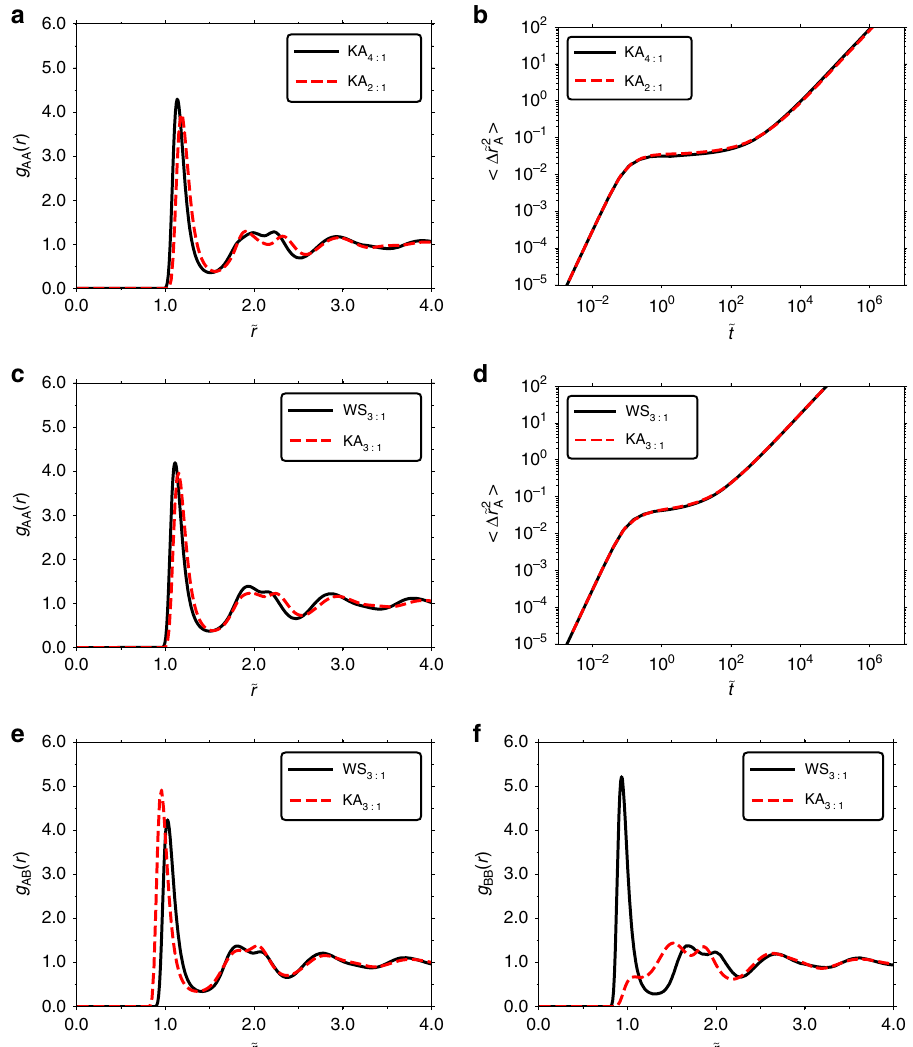
Fig. 5 Tests of radial distribution function (RDF) quasiuniversality where e r ¼ ρ 1 = 3 r and e t ¼ t ρ 1 = 3 ð k B T = m A Þ 1 = 2 . a AA-particle RDFs for the KA mixture for two different compositions (4:1 and 2:1) at state points with almost identical S ex and e D A . For 4:1 KA: ρ = 1.204, and T = 0.440 and for 2:1 KA: ρ = 1.400, and T = 0.550. b A-particle MSDs with details given in a , demonstrating almost identical reduced diffusion coef fi cients. c AA-particle RDFs for the KA and WS mixtures at the same 3:1 composition for state points with almost identical S ex and e D A . For 3:1 KA: ρ = 1.400 and T = 0.900 and for 3:1 WS: ρ = 1.100 and T = 0.415. d A-particle MSDs with details given in c . e AB-particle RDFs with details given in c . f BB-particle RDFs with details given in c .